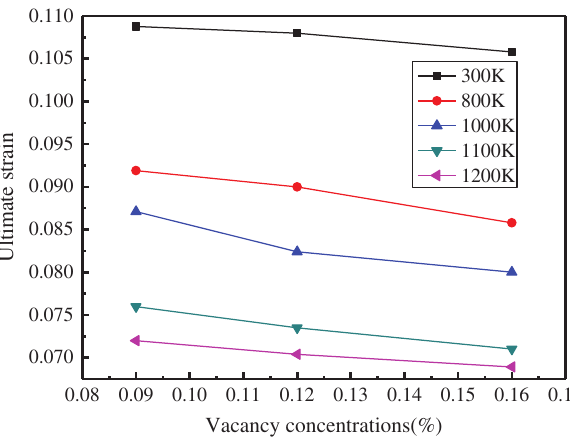
Figure 7: Elastic modulus curves at different temperatures and vacancy